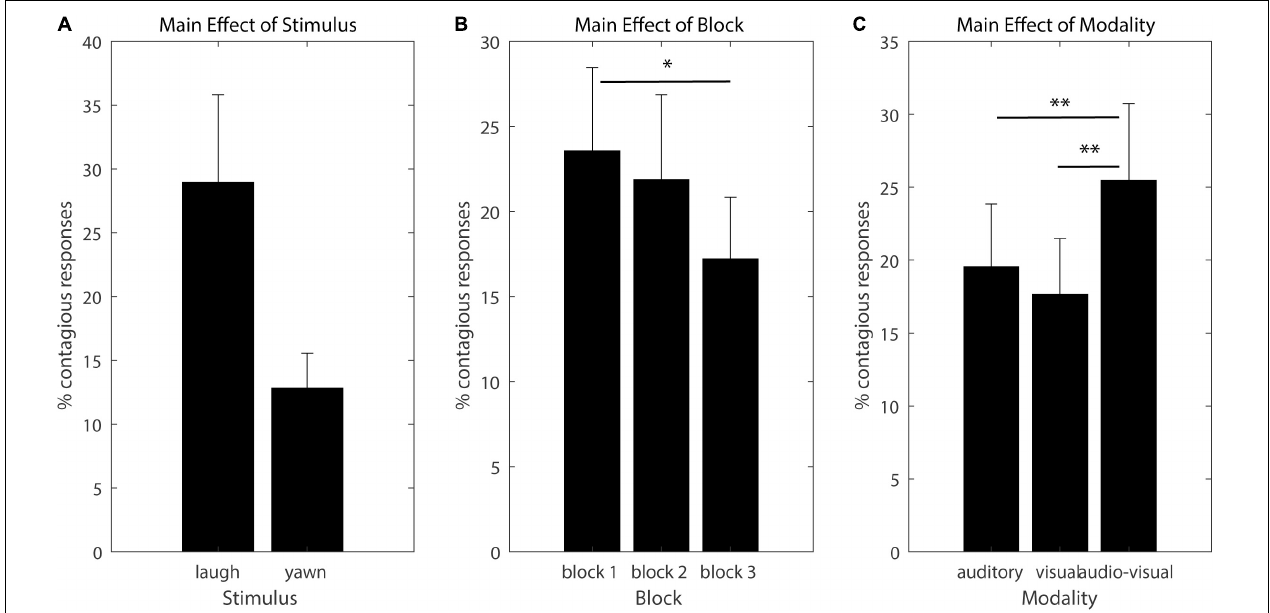
FIGURE 1 | Significant main effects. The y axis denotes the percentage of trials of contagious responses, bars denote marginal means for each condition and error bars denote standard errors. Significant linear contrasts (FDR corrected for multiple comparisons) are indicated by asterisks ( ∗ p < 0.05, ∗∗ p < 0.01, and ∗∗∗ p < 0.001). (A) main effect of Stimulus, (B) main effect of Block, (C) main effect of